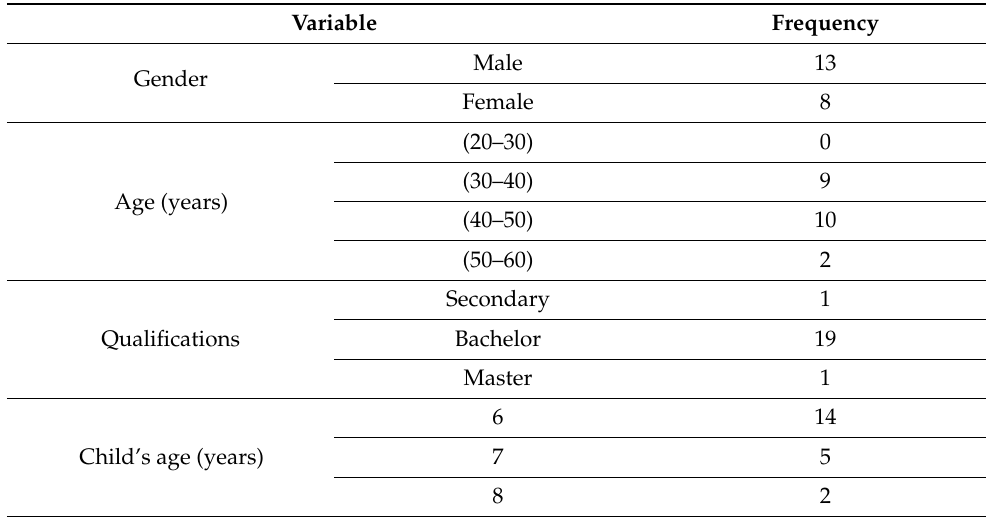
Table 1. Demographic information of parents ( n =